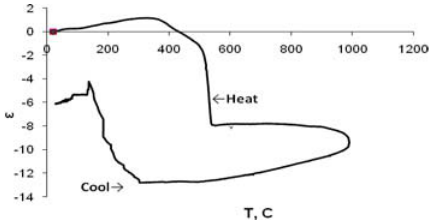
Fig. 1. Dilatometric curve of the Zr-Cu-Nb based nanostructural alloy.